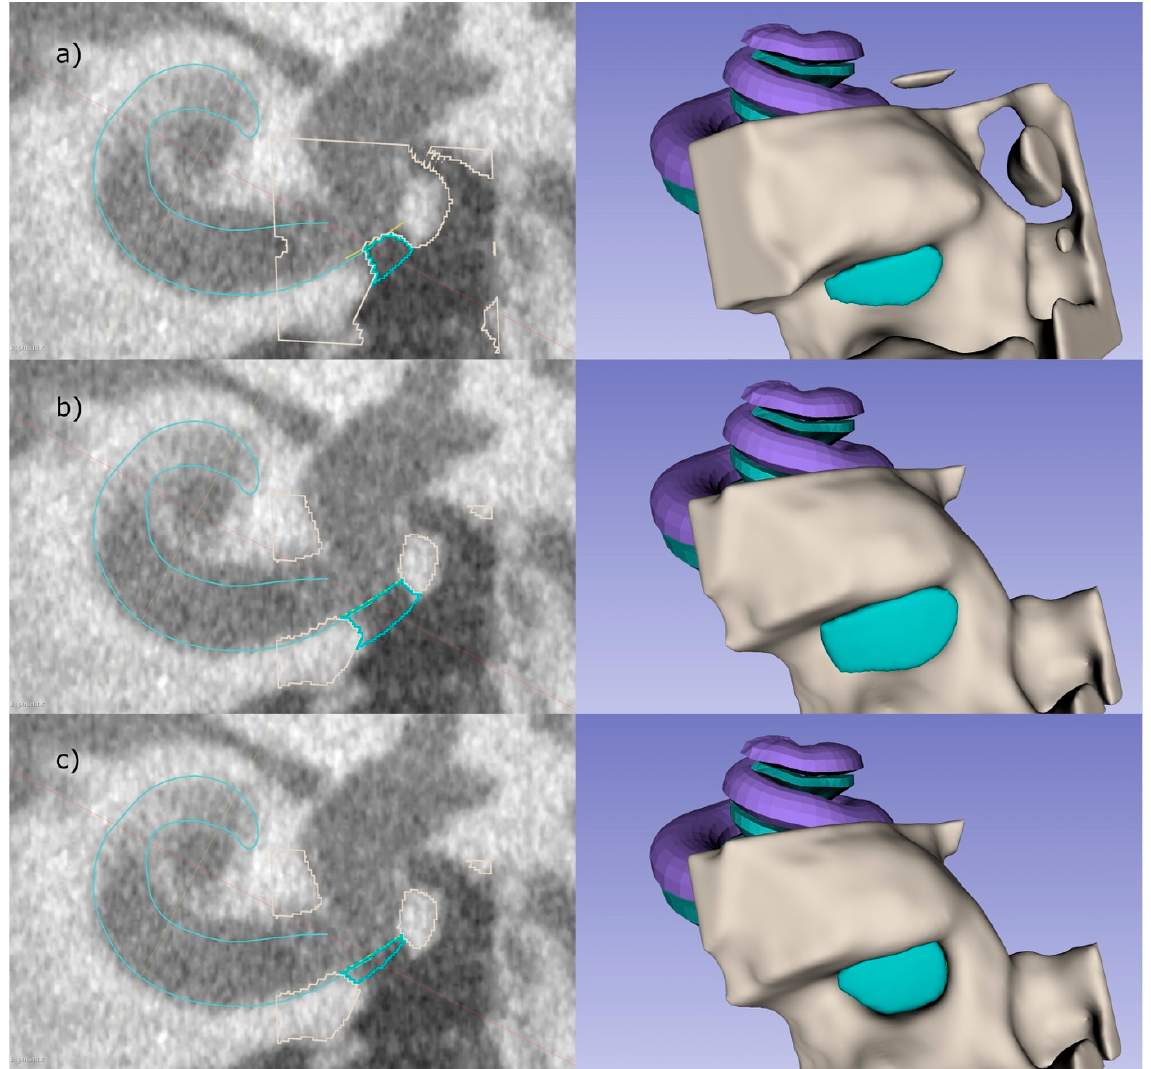
Figure 5. The user has several options to influence the final shape of the implant: ( a ) shows the lower threshold for bone, resulting in a smaller implant compared to the automatic threshold used in ( b ). In ( c ) the level to which the niche is filled is manually reduced. The right images illustrate the RWN‐filling corresponding to the related left images.